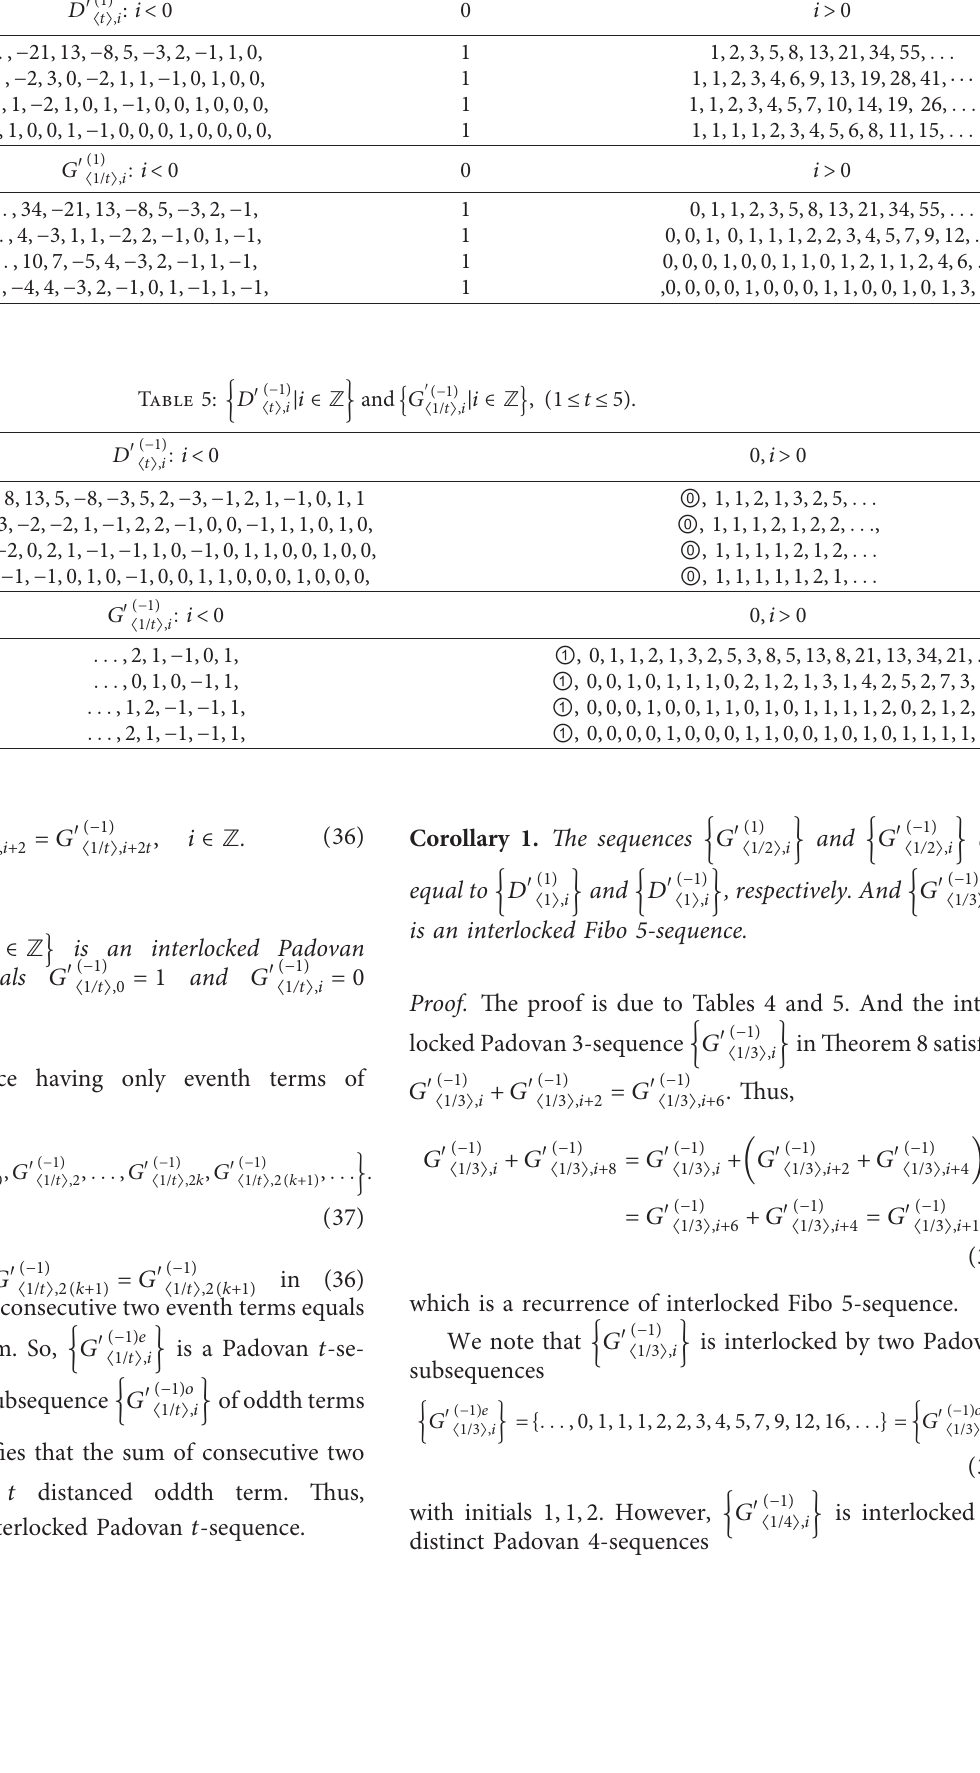
| i ∈ Z 􏽮 􏽯 and G ′ ( 1 ) 〈 t 〉 ,i